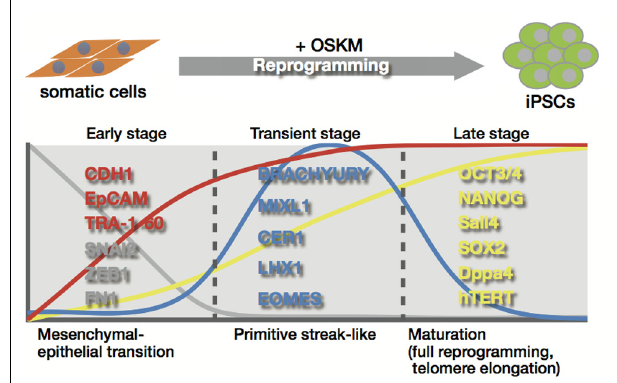
FIGURE 3 |Telomere rejuvenation by reprogramming. The reprogramming process is divided into three distinct stages; early stage, transient stage, and late stage.Telomerase activation and telomere elongation occur in the late stage by induction of telomerase reverse transcriptase subunit and the telomerase RNA (TERC) component, which induce telomere rejuvenation similar in length and their epigenetic state to those of